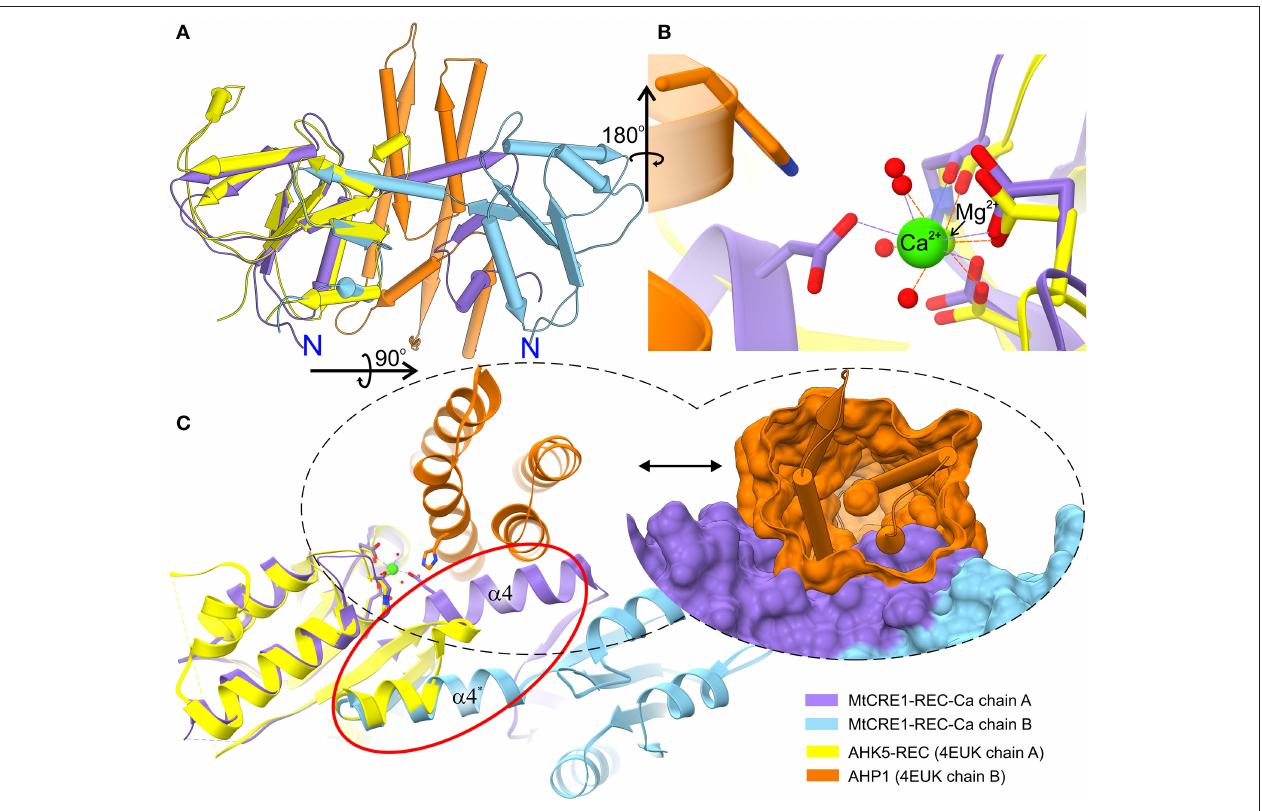
FIGURE 3 | Superposition of the MtCRE1-REC dimer (purple/blue) onto the AHK5-REC (yellow) complex with AHP1 (orange) (A) . MtCRE1-REC and AHK5-REC share a similar flavodoxin-like core structure. They also have a similar metal-binding site, shown in stick representation (B) . While MtCRE1-REC binds Ca 2 + , AHK5-REC binds Mg 2 + . An attempt to superpose the two structures leads to severe clashes between AHP1 (orange surface) and MtCRE1-REC (purple surface), as shown in (C) . The clashes occur because of the presence of the swapping domain (circled in red). In MtCRE1-REC, the purple α helix juts toward the second subunit (blue), while in AHK5-REC it flips back in the opposite direction